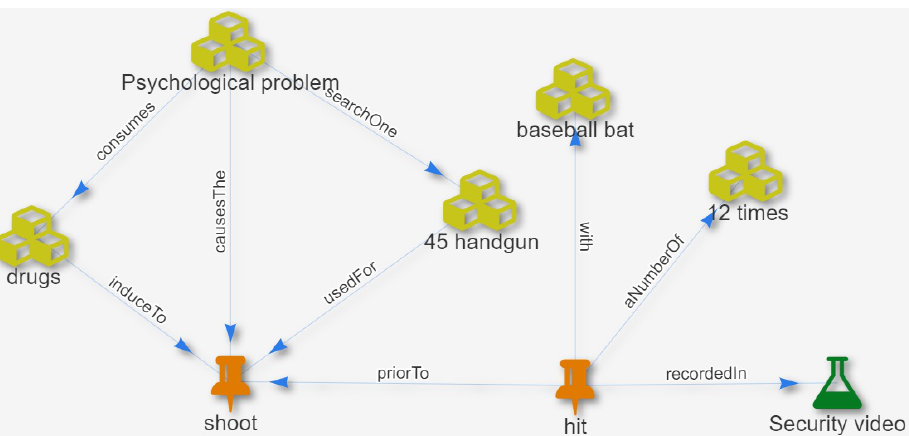
Figure 14. The graphic interface of images according to the interpretation and assessment made by a judge. A piece of a real scene in a murder case using a